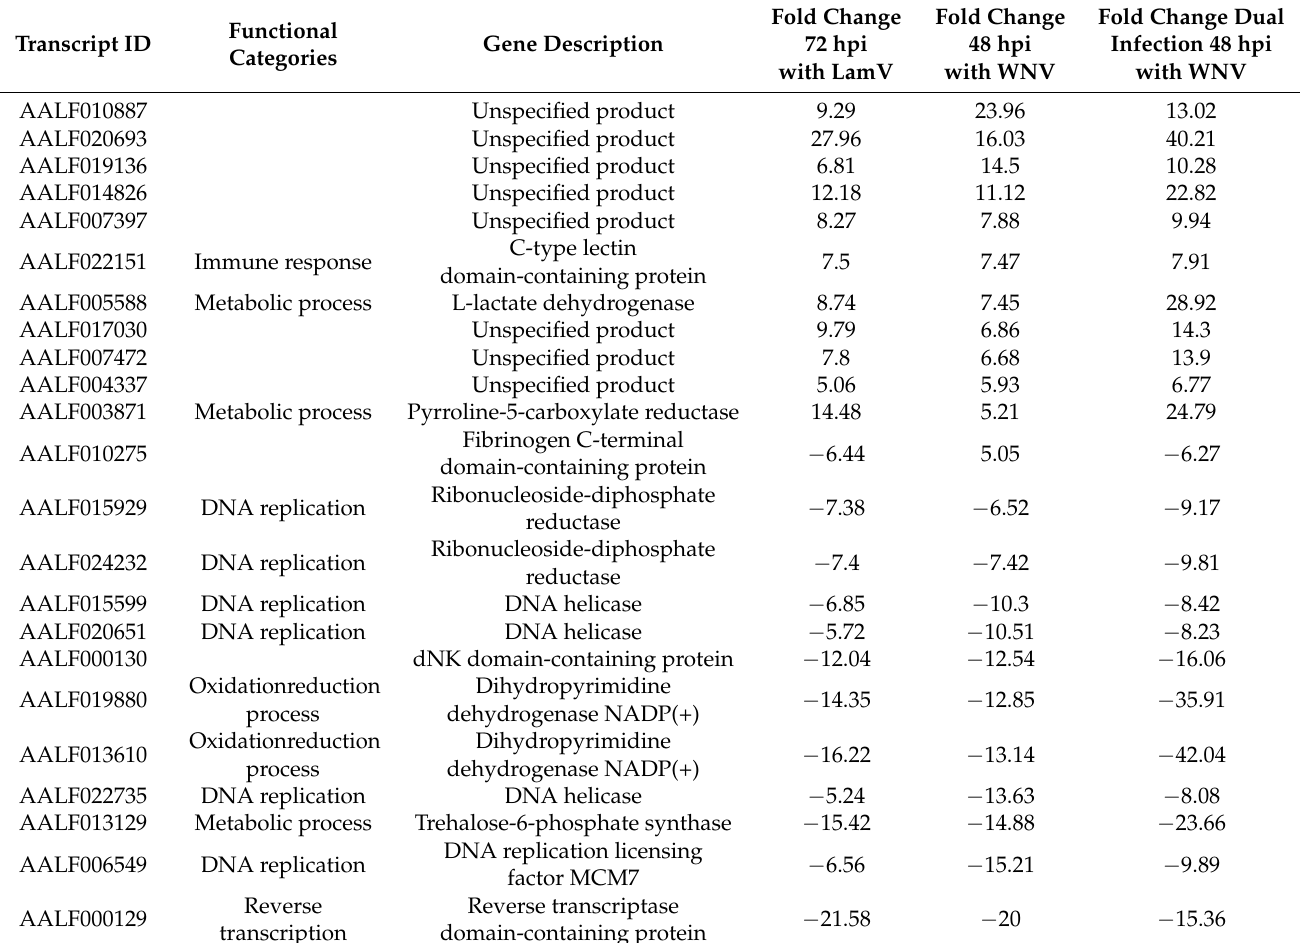
Table 4. List of Ae. albopictus overlapping differentially expressed transcripts among LamV at 72 hpi, WNV 48 hpi and dual-infected cells 48 h post-challenge with WNV. Functional categories are based on GO terms for biological processes. The cut-offs used were p -adjusted value of ≤ 0.01 and log 2 FC of ≥